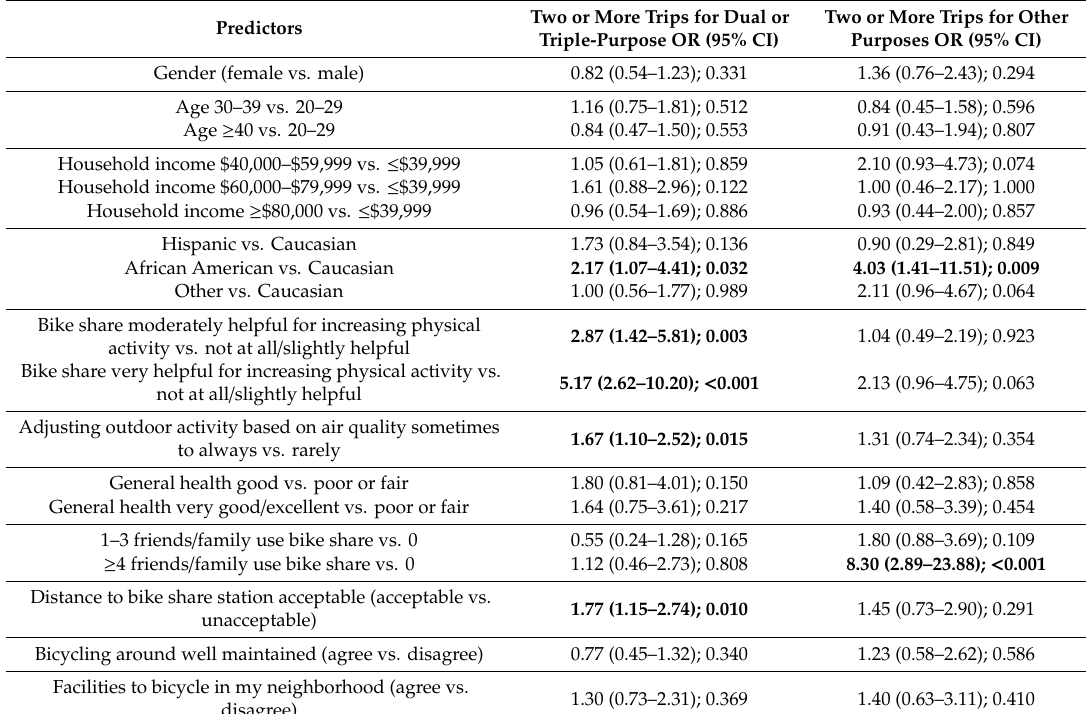
Table 3. Likelihood of making two or more trips per week in the past six months for dual or triple-purpose and other purposes. Significant predictors are in